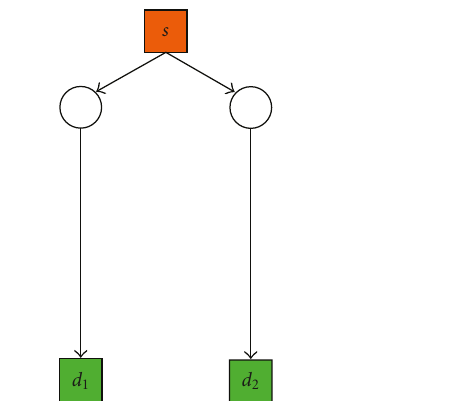
Figure 7: Steiner tree corresponding to indicator vector e = [1,1,1,0,0,1,0,0,0].